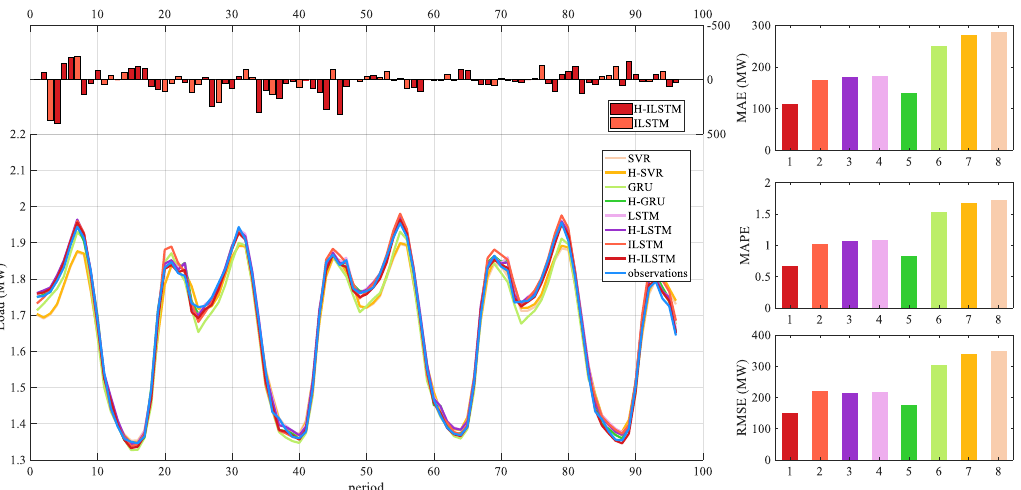
Figure 10. Forecasting performance of eight models for dataset 1.